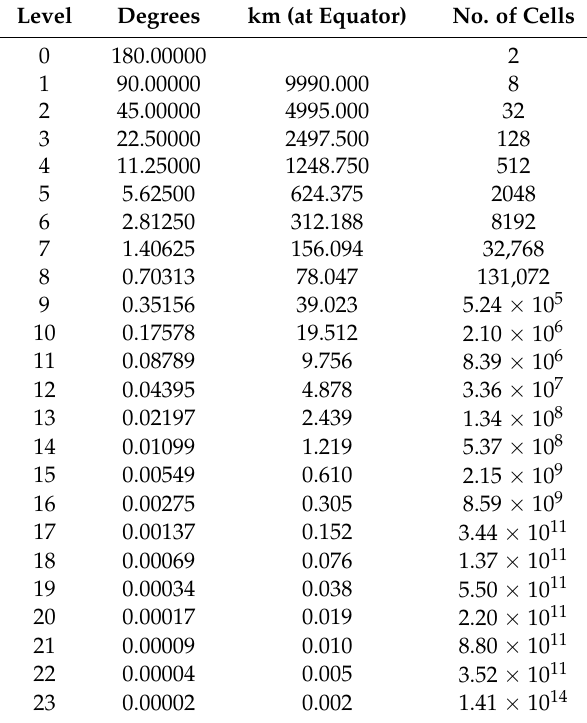
Table 1. The length of a side of a cell (in degrees and kilometers) and number of cells for each level of the Global